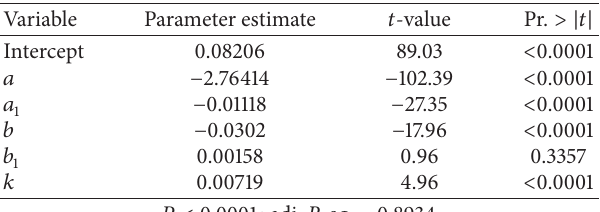
Table 9: Statistics of multiple linear regression for sampling level for selected sampling experiments.